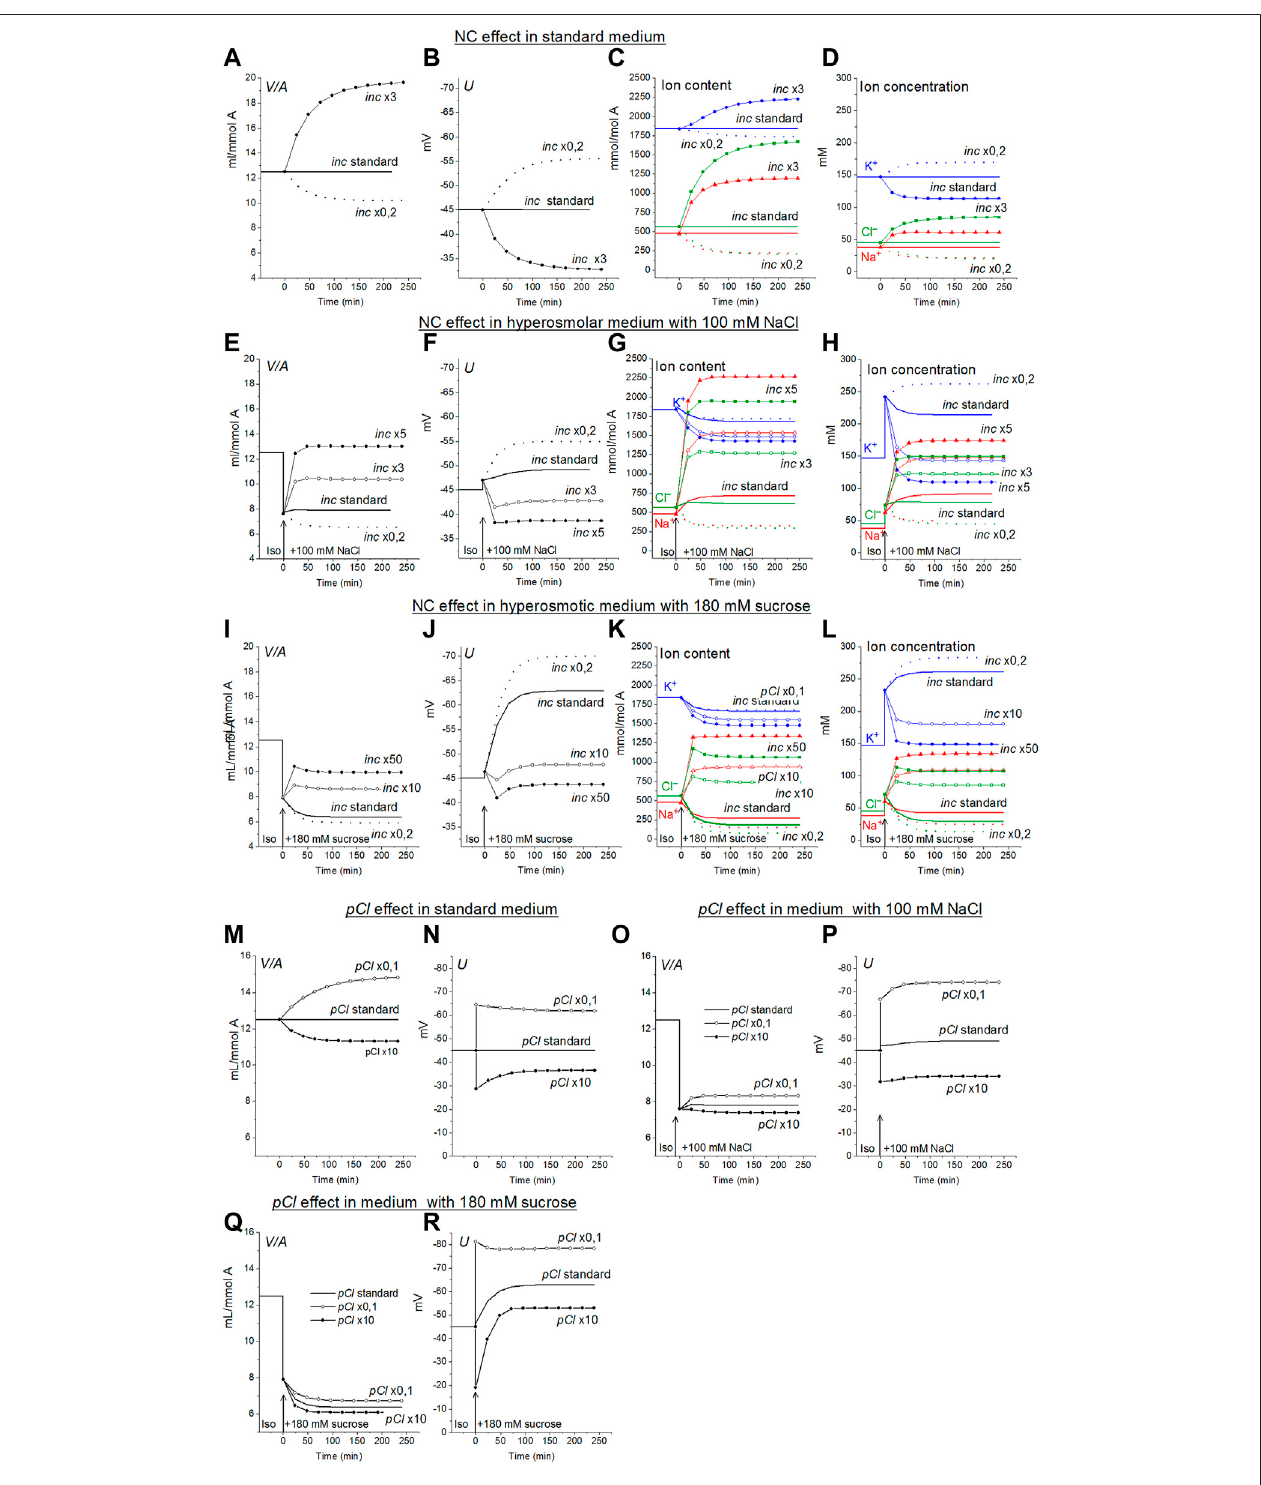
FIGURE3| TheeffectsofNCratecoef fi cient (A – L) andpermeabilitycoef fi cientofCl − channels (M – R) ontheionichomeostasisinU937cellmodel understandard conditions and after transition to hyperosmolar medium with 180 mM sucrose or 100 mM NaCl. The calculation was carried out for a model with a full set of cotransporters. Changes inNC ratecoef fi cient ( inc ) and in permeability coef fi cient ofCl − channels ( pCl ) are shown in the graphs, other parametersremained unchanged and are shown in Table 2